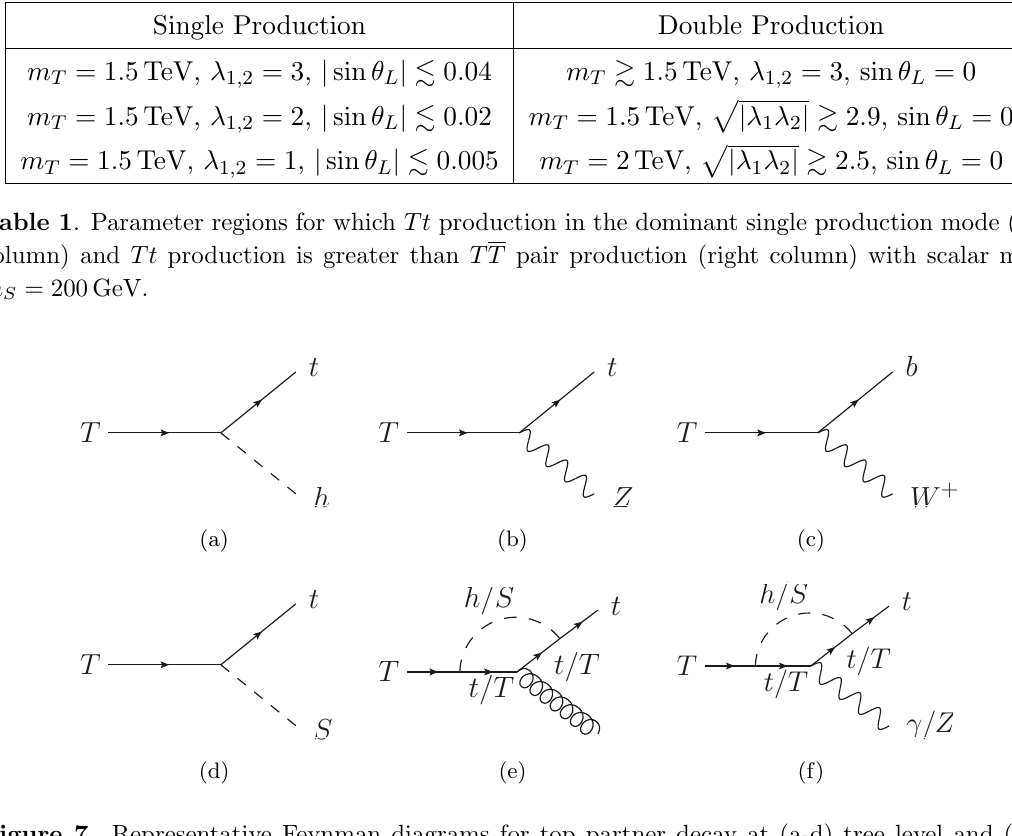
Figure 7 . Representative Feynman diagrams for top partner decay at (a-d) tree level and (e-f) one-loop level. Not shown here are external self-energies, external vacuum polarizations, or loops with Goldstone, W , or Z